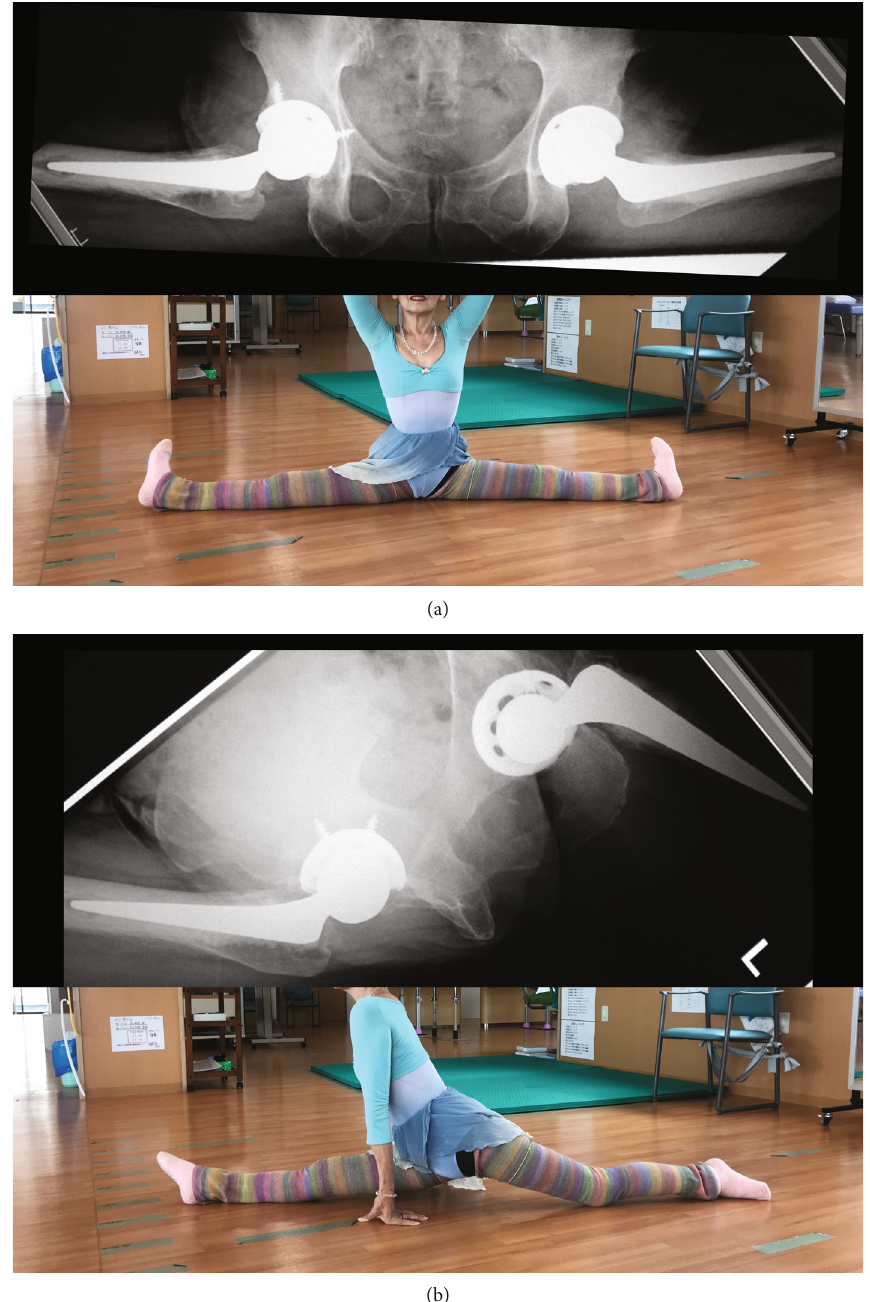
Figure 4: Postoperative radiograph with two types of characteristic postures in ballet. The patient was demonstrating the split position. These views were obtained with cassettes by getting as close as possible to the patient ’ s back during the actual postures. The radiograph did not show any characteristics of bony impingement, implant-implant impingement, or subluxation of the femoral head: (a) split position; (b) left split